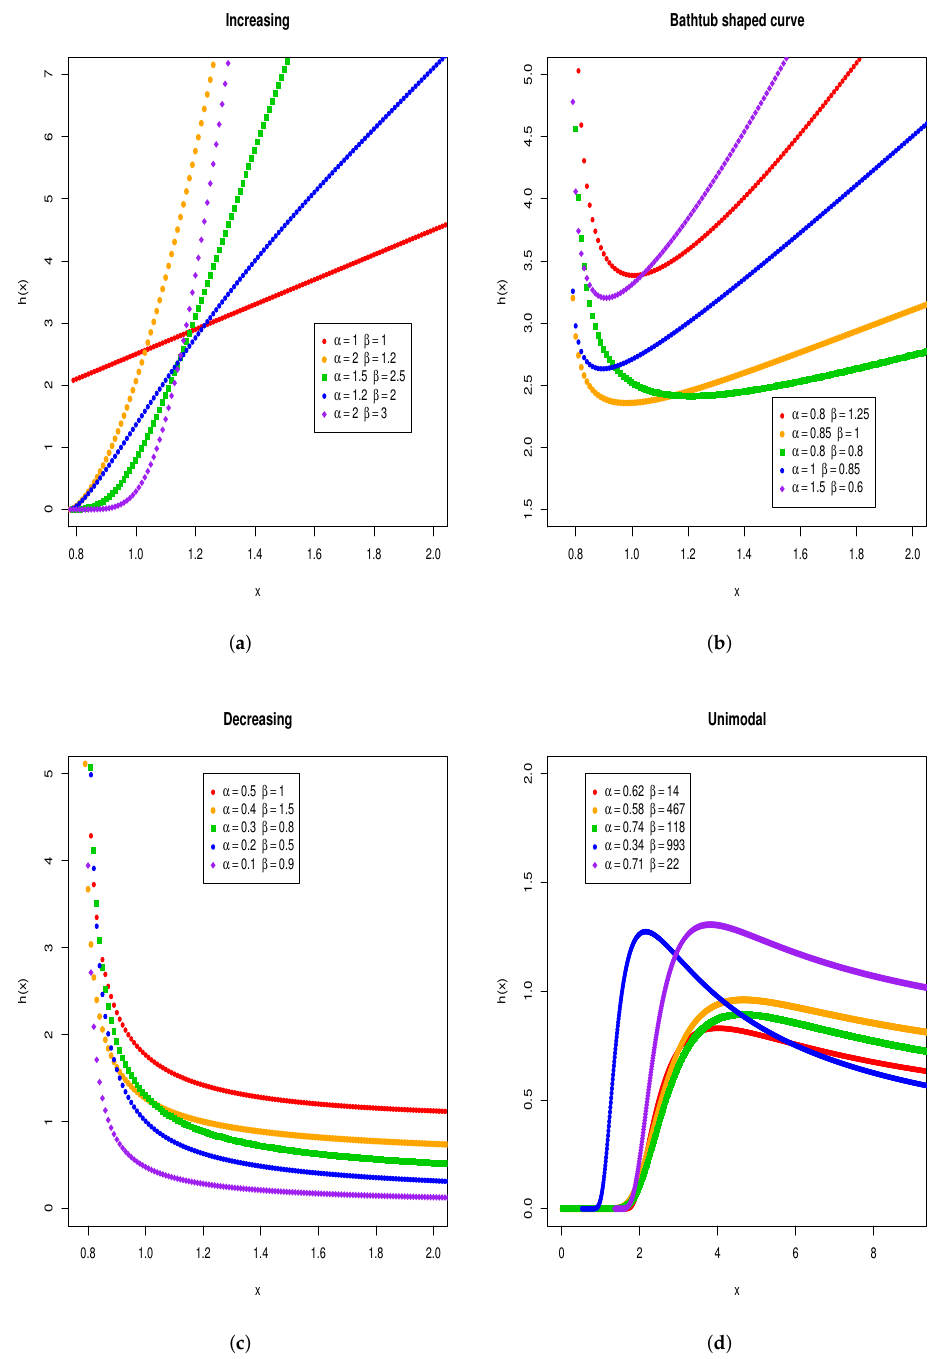
Figure 2. Plots of the hazard rate functions of the NEGLED. ( a ) α > ( 1/2 ) + , αβ > 1; ( b ) α > ( 1/2 ) + , αβ < 1; ( c ) α < ( 1/2 ) + , αβ < 1; ( d ) α < ( 1/2 ) + , αβ >